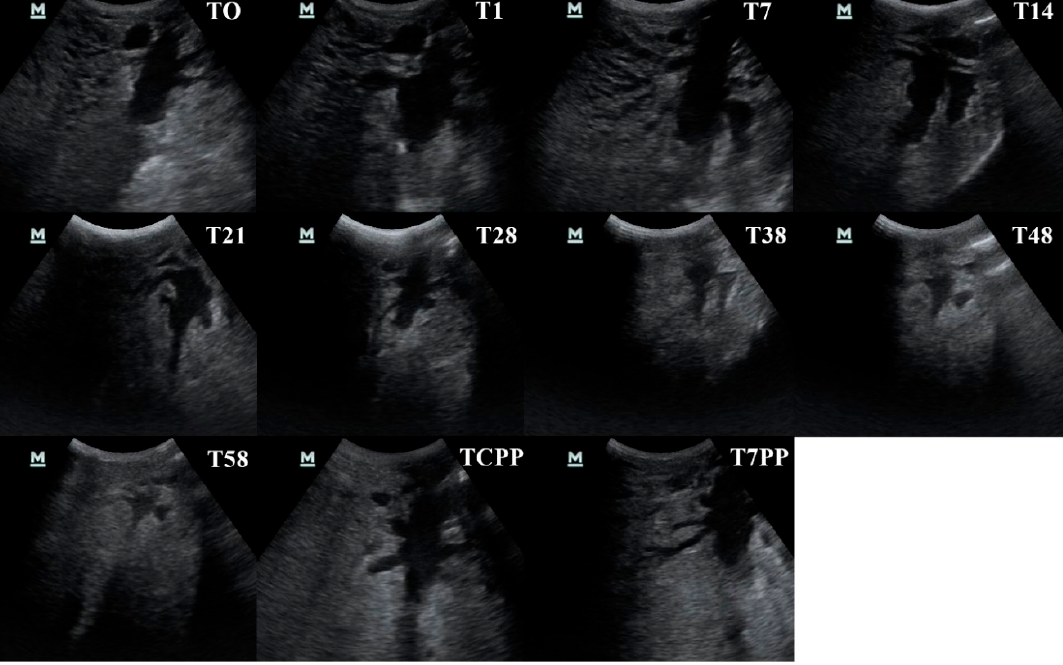
Figure 8. The udder cistern size as revealed by ultrasonography throughout the study period (T0, T1, T7, T14, T28, T38, T48, T58, T colostrum production phase—TCPP and T 7 days post-partum—T7PP) of the hind quarter in the longitudinal section in the same healthy cow.